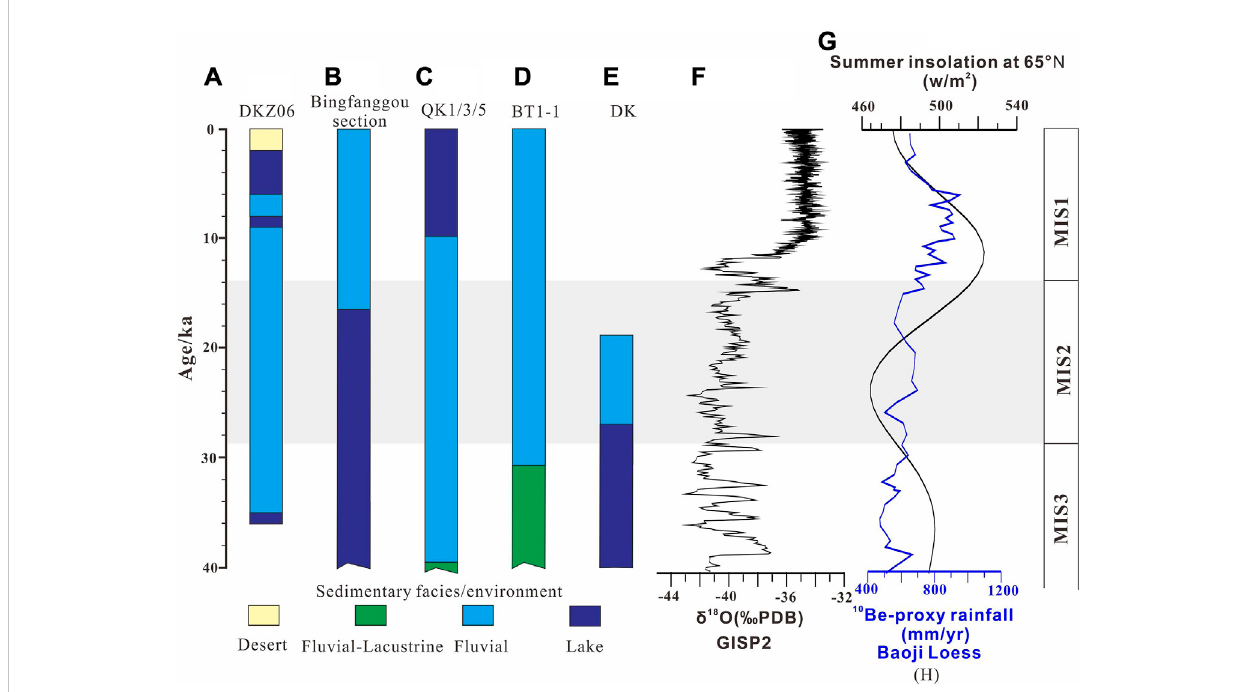
FIGURE 6 Relationships between the sedimentary environment and climate change during the Late Pleistocene. (A) Sedimentary facies of core DKZ06. (B) Sedimentary facies of the Bingfanggou section (Yang et al., 2018). (C) Sedimentary facies of cores QK1, QK3, and QK5 (Liu et al., 2014). (D) Sedimentary facies of core BT1-1 (Zhao etal.,2016). (E) Sedimentary facies of core DK(Yang etal., 2020). (F) δ 18 Orecord ofGISP2(Stuiverand Grootes,2000). (G) Plot of 65 ° N summer insolation (Berger and Loutre, 1991). (H) 10 Be-proxy rainfall of Baoji Loess (Beck et al.,